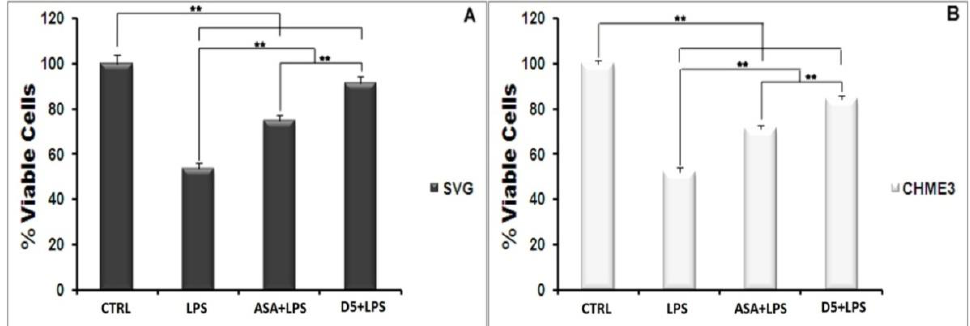
Figure 1. Cytotoxicity Test of D5 (0.71 µM) compared to ASA (52.73 µM), LPS-treated (positive control), and LPS-untreated (negative control) groups. Both SVG astrocytic glial and CHME3 mi- croglial cells were treated with LPS + Drugs for 24 h. Cytotoxicity of D5 was examined using MTT assay (2 mg/mL). The cell viability was measured as % of the amount of formazan formation in the control unstimulated group. ( A ) the D5 cellular toxicity in the selected dose in the SVG cell line; ( B ) the cellular toxicity of D5 in the selected dose in CHME3 cell lines. Data were presented as the mean ± S.D. of four samples in one independent experiment. The data were replicated in three repeated independent experiments. ** p < 0.01